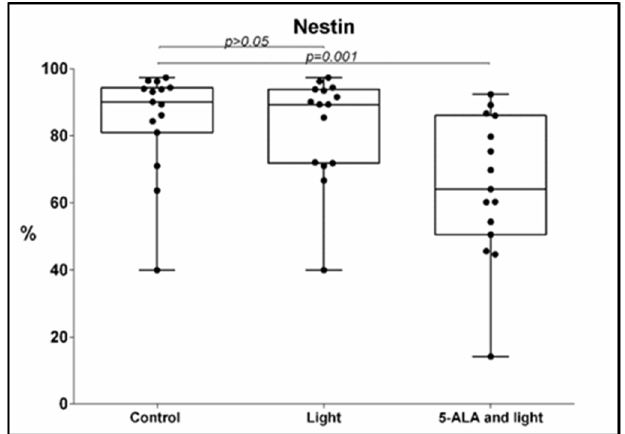
Figure 2. Boxplot showing the change in the percentage of Nestin-positive GB-MSCs across paired samples of control cell cultures, cell cultures treated with light only, and cell cultures exposed to 5-ALA and light. Nestin expression was evaluated using multi-color flow cytometry, and every dot on the box plot represents the percentage values of all Nestin-positive GBM-MSCs in that particular cell culture.